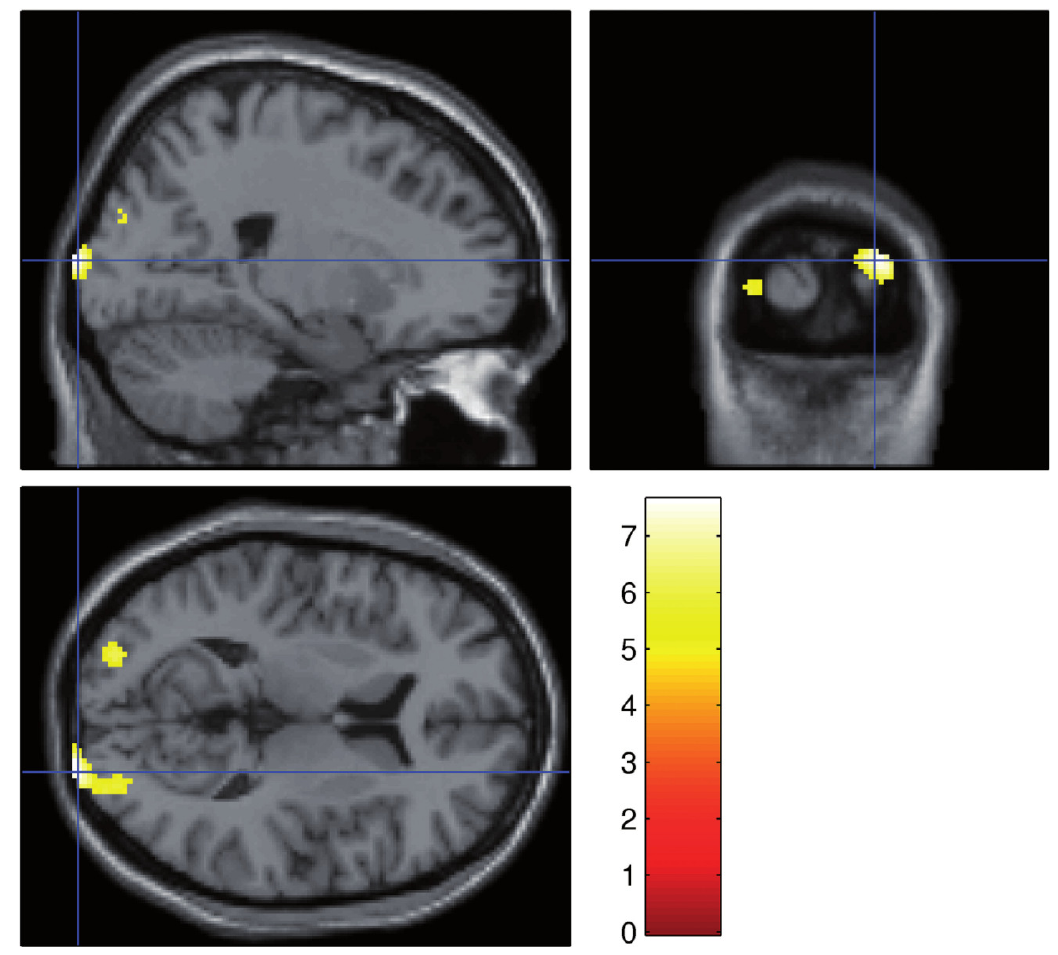
Figure 9. Single-subject fMRI results of the visual stimulation paradigm as used in Figures 7b and 8b (p < 0.001,